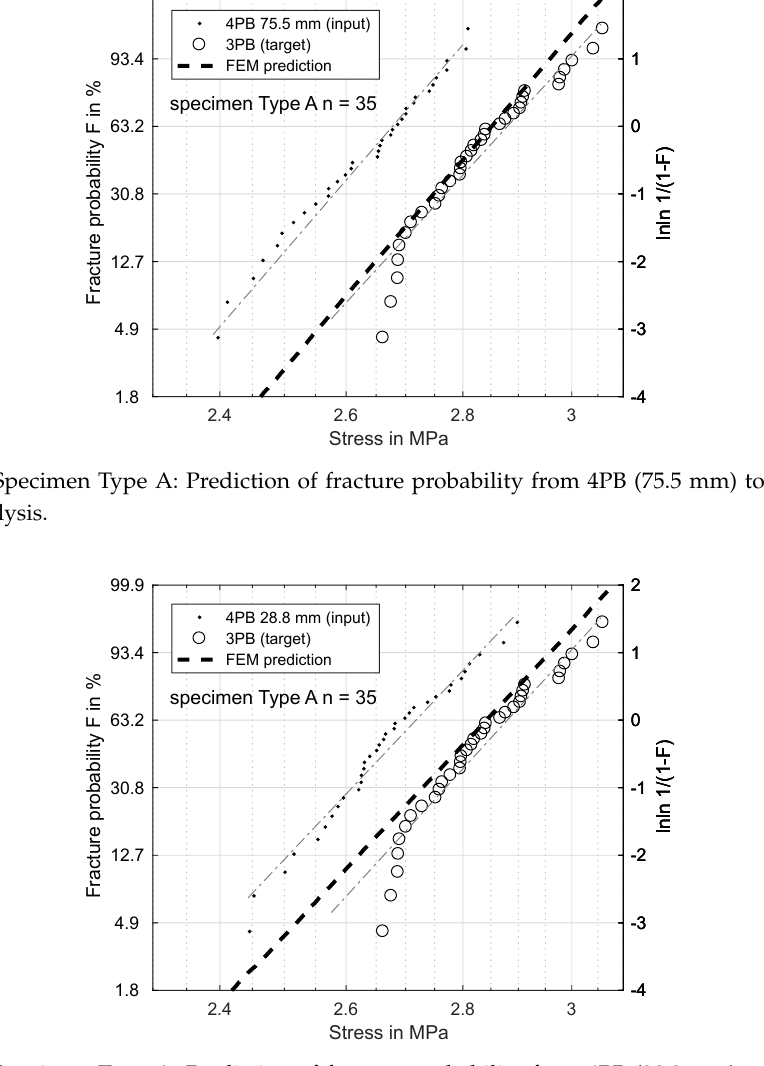
Figure 14. Specimen Type A: Prediction of fracture probability from 4PB (28.8 mm) to 3PB based on FEM